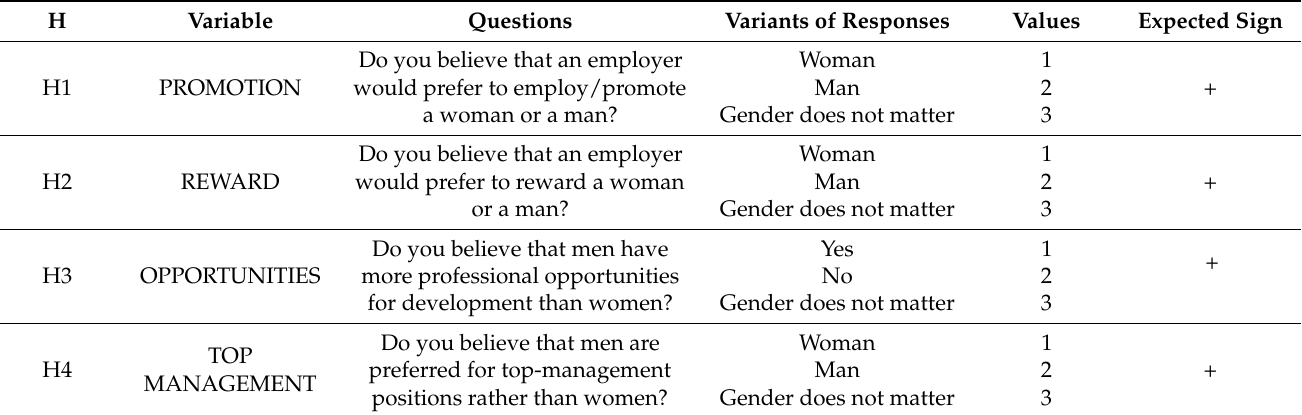
Table 1. Institutional factors.